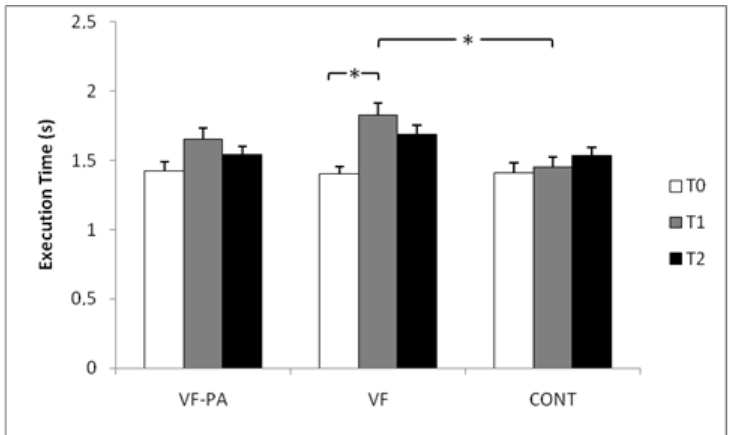
Figure 4. Execution time (mean ± standard deviation) at T0, T1 and T2 among the three groups. VF-PA: Video Feedback with Pedagogical Activity group; VF: Video Feedback group; CONT: Control group. * Significant difference at p < 0.01.